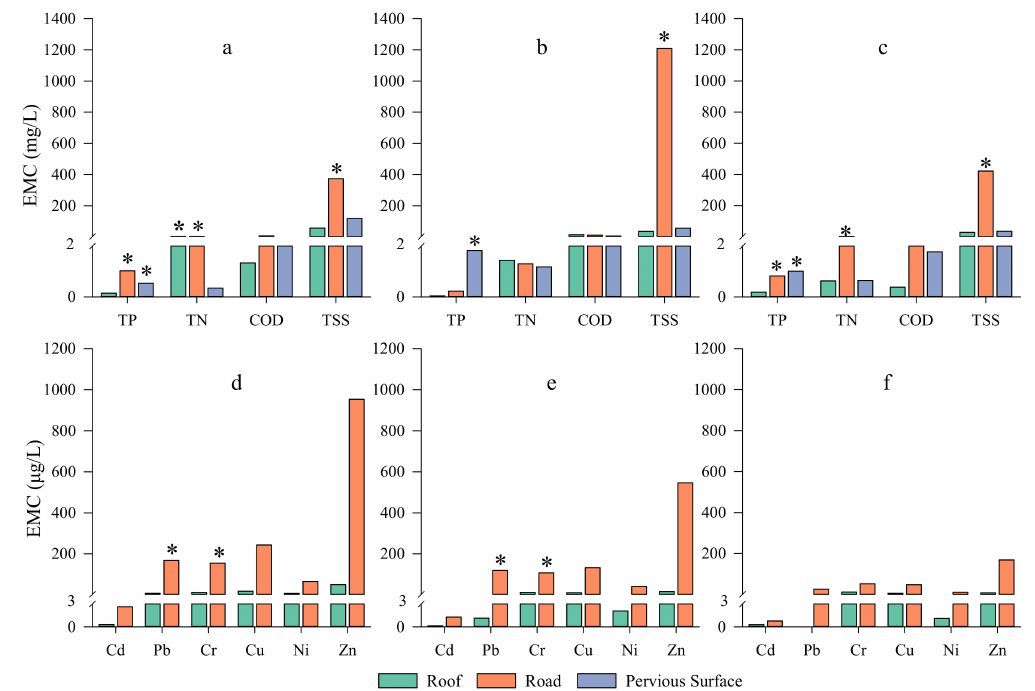
Figure 8. The average event mean concentration (EMC) values of total phosphorus (TP), total nitrogen (TN), chemical oxygen demand (COD), total suspended solids (TSS) and six heavy metals (Cd, Pb, Cr, Cu, Ni, and Zn) for different underlying surfaces and rainfall intensities. ( a ) and ( d ) EMC values of urban non-point source (NPS) pollutants in light rain; ( b ) and ( e ) EMC values of urban NPS pollutants in moderate rain; ( c ) and ( f ) EMC values of urban NPS pollutants in heavy rain. * The concentration of the NPS pollutant constituent exceeded the